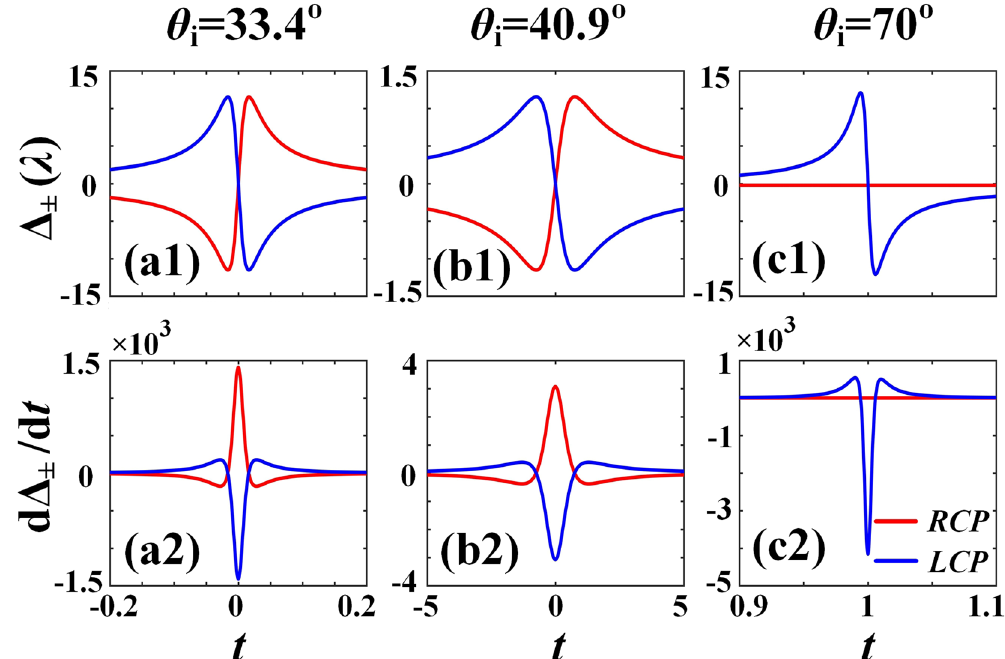
Figure 4. The dependences of displacements Δ ± and sensitivities d Δ ± /d t of the RCP and LCP components of the reflected beam on the initial amplitude ratio t for different incident angles. (a1,a2) θ i = 33.4°, (b1,b2) 40.9°, and (c1,c2)